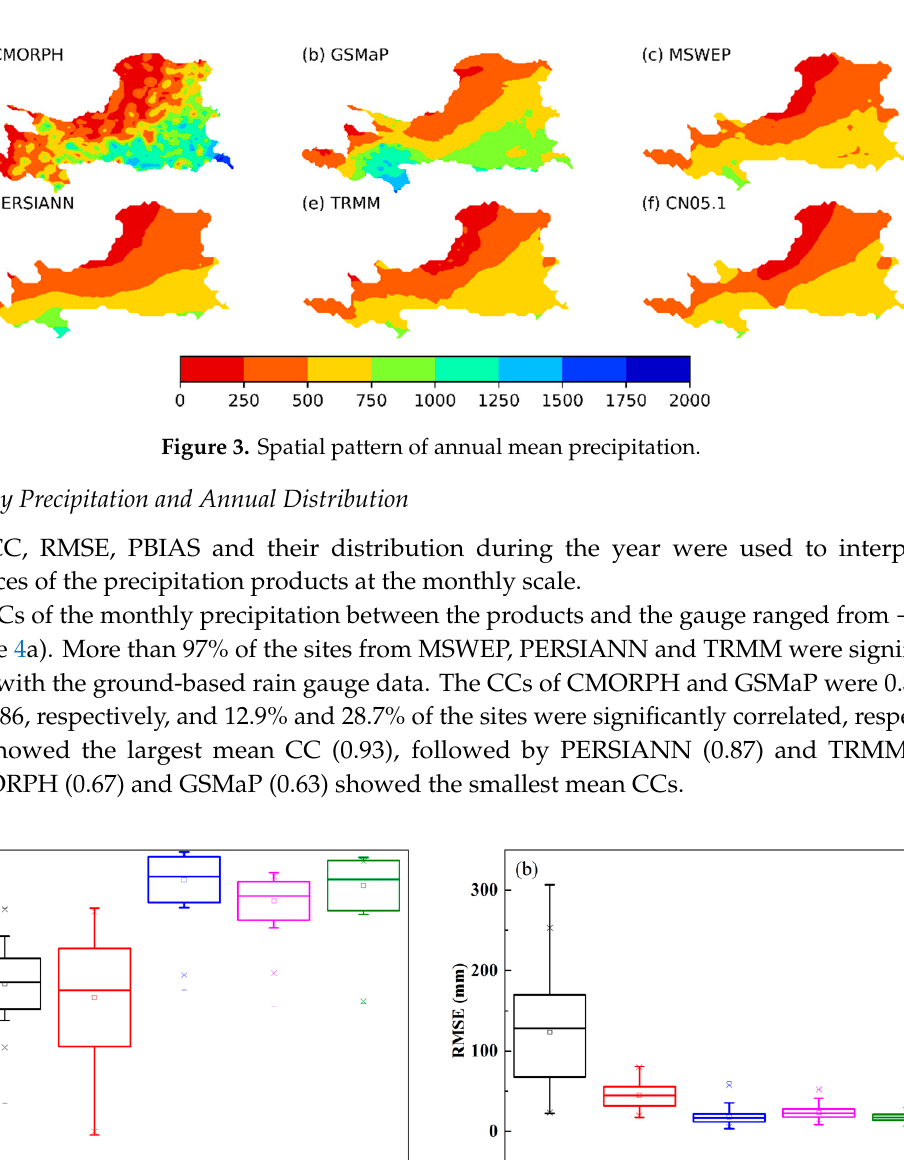
8 of 25 Figure 2. ( a ) correlation coefficient, ( b ) root mean square error of annual precipitation between gridded and gauge datasets, and ( c ) temporal variation of annual precipitation. CC is correlation coefficient, RMSE is root mean square error. (The center line of each boxplot depicts the median value (50th percentile) and the box encompasses the 25th and 75th percentiles of the sample data. The small squares in each boxplot is the arithmetic mean. The whiskers extend from Q1 – 1.5 × (Q3 – Q1) to Q3 + 1.5 × (Q3 – Q1), where Q1 and Q3 are the 25th and 75th percentiles of the sample data, respectively, similarly hereinafter). The five products and ground-based rain gauge data showed that the annual precipitation decreased from southeast to northwest (Figure 3), which was consistent with the distribution of climatic conditions in the Yellow River Basin. The contour map of precipitation in the literature showed that the southern part of the Yellow River Basin received the largest amount of precipitation